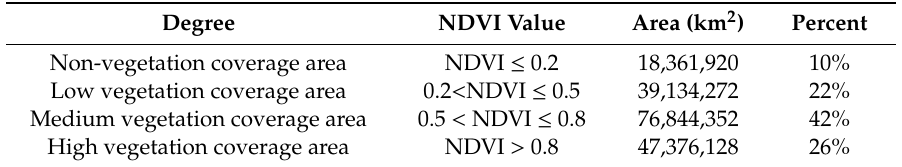
Table 1. Global vegetation coverage distribution of all levels. NDVI: (normalized di ff erence vegetation